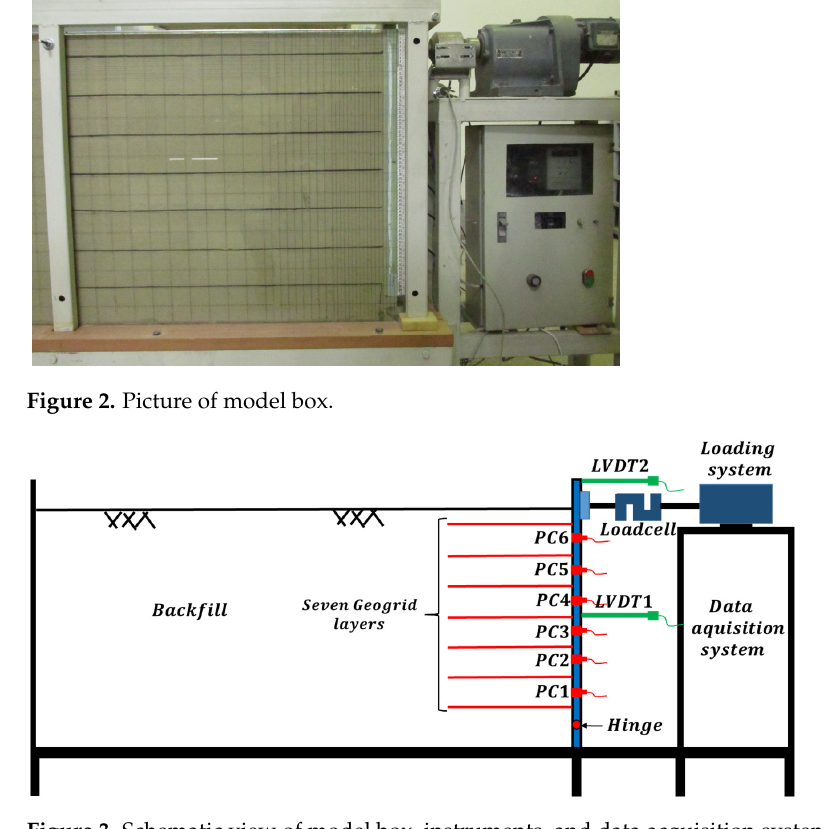
Figure 2. Picture of model box.